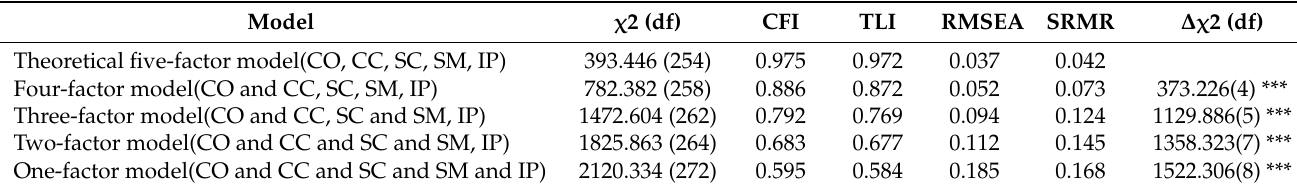
Table 5. Model fit statistics for measurement models.